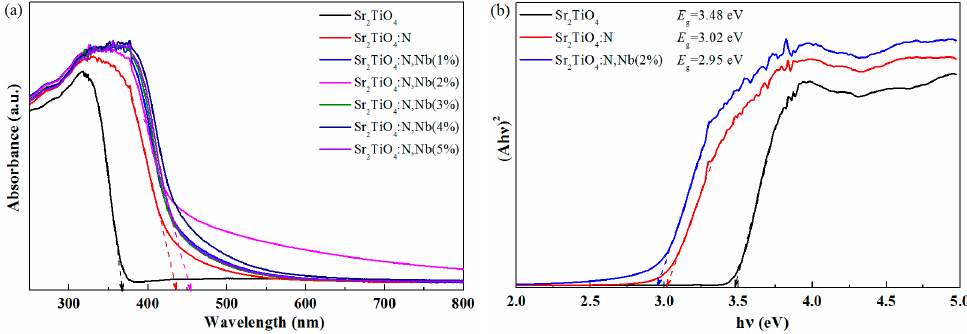
Figure 4. UV-Vis spectra ( a ) and Tauc plots ( b ) of Sr 2 TiO 4 , Sr 2 TiO 4 :N, and Sr 2 TiO 4 :N,Nb(2%).